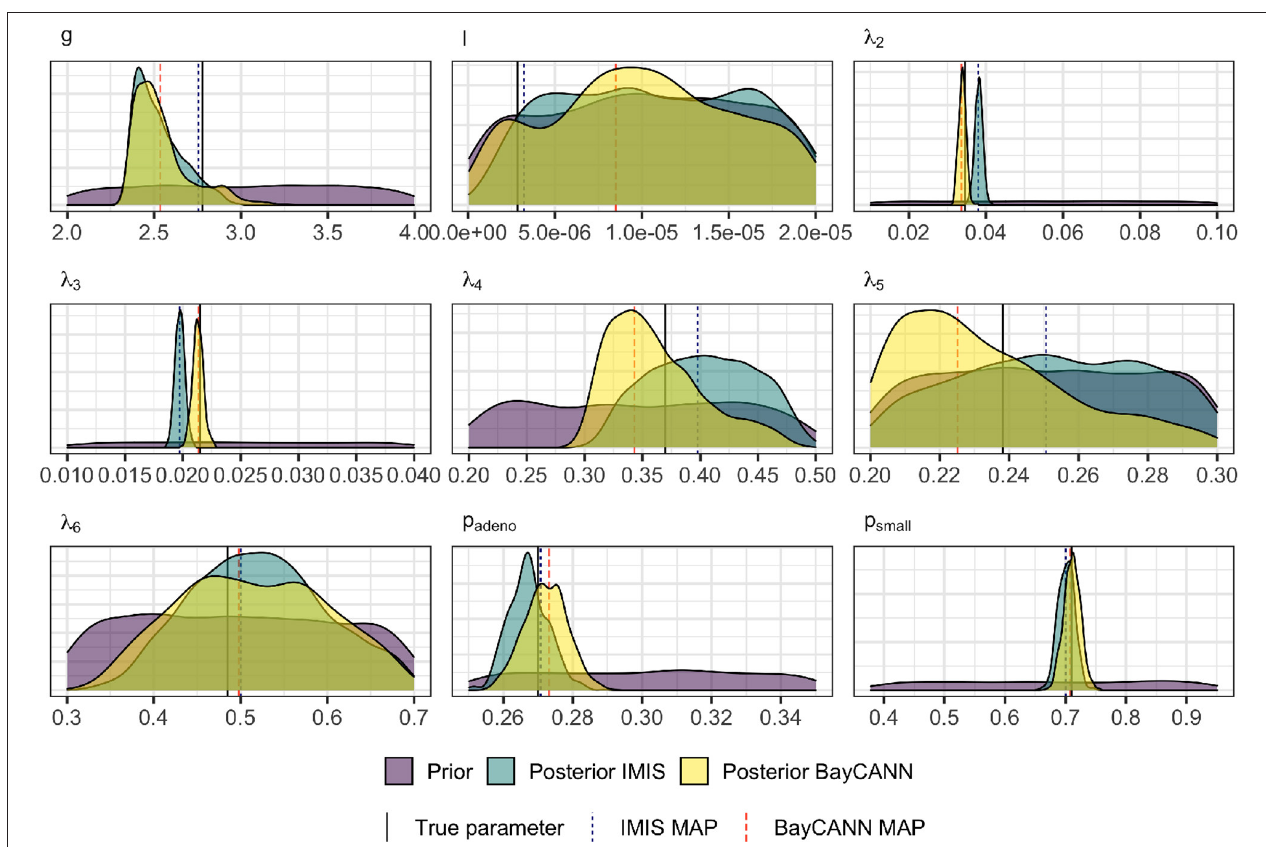
FIGURE 5 | Prior and Marginal posterior distributions of the calibrated parameters from the IMIS and BayCANN methods. The vertical solid lines indicate the “true” parameter values (i.e., the value of the parameters used to generate the calibration targets in the confirmatory analysis). The vertical dashed lines represent the maximum a posteriori (MAP) for BayCANN and the incremental mixture importance sampling